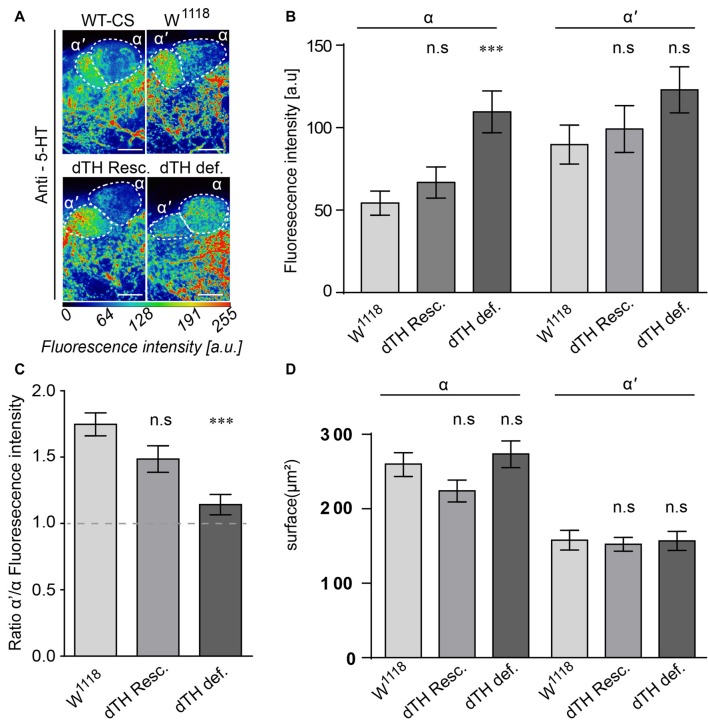
5-HT neurons projecting to the MB show altered innervation densities in DA-deficient flies. (A) Innervation patterns of 5-HT neurons to the α/α’-lobe of the MB. Under wild-type conditions, 5-HT producing neurons innervate strongly the tips of the α’ but only faintly the α lobes. In DA-deficient flies, 5-HT innervations to the α lobes are markedly increased. Scale bar: 10 μm (B) Fluorescence intensity analysis of the 5-HT IR in α– and α’-lobes. 5-HT innervations to the α-lobes are increased in flies lacking neuronal TH when compared to control flies. (C) Ratio of 5-HT innervation density between α’- and α-lobes. Under control conditions, 5-HT neurons innervate α’-lobes stronger than the α lobes. In DA-deficient flies, 5-HT-neuron α-lobe innervations are increased and comparable to the α’-lobe innervations. (D) The surface of the α/α’-lobes that are targeted by 5-HT neurons is not altered between DA-deficient and control flies (Dunn’s multiple comparison test against w1118, n < 13). n.s.: p > 0.05; ***p < 0.001.